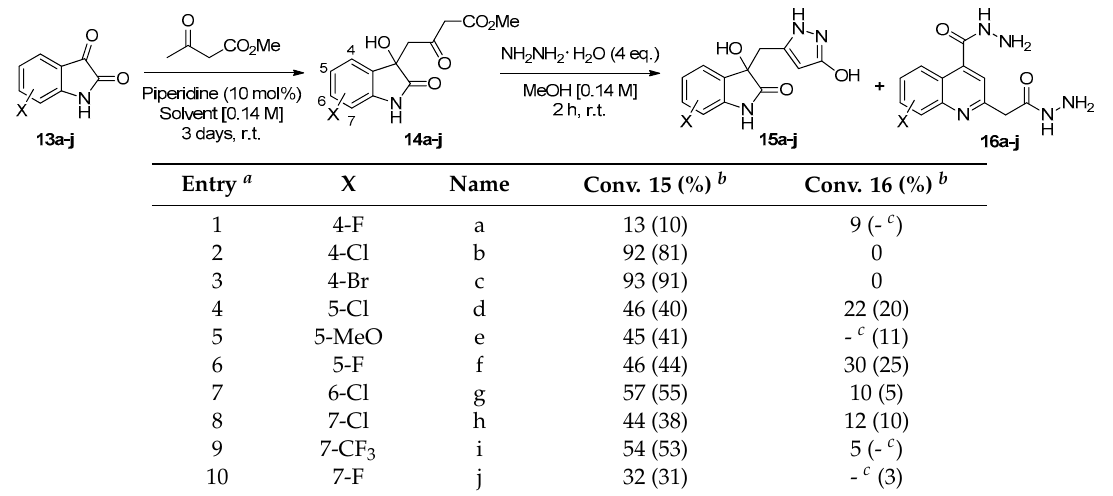
Table 4. Application of the optimised conditions for the synthesis of the derivatives 15a – j .